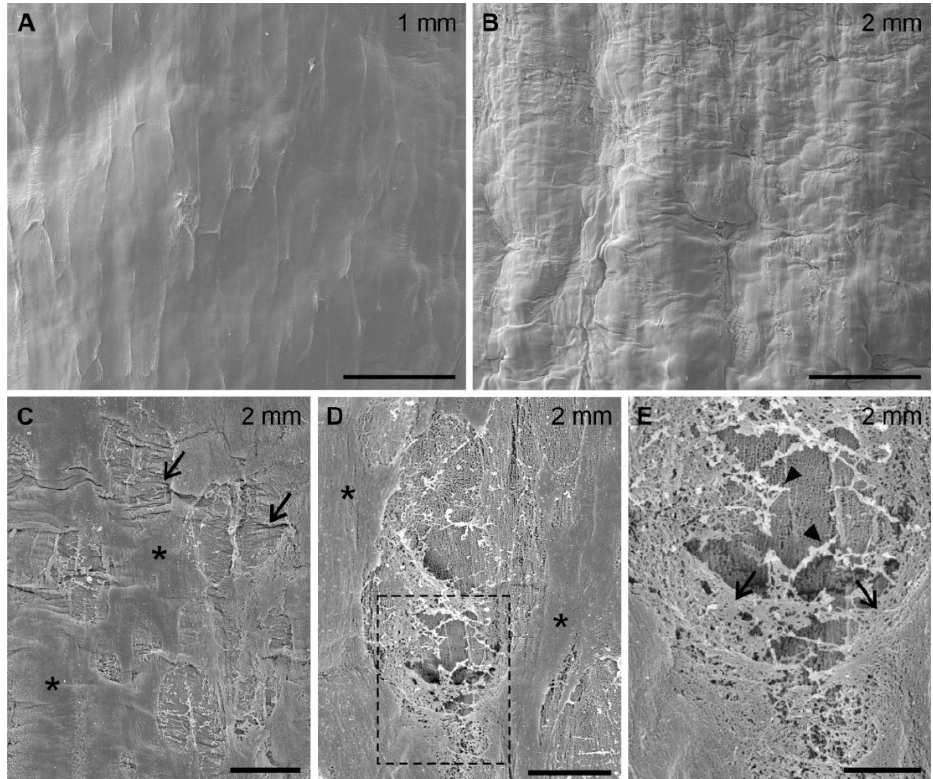
Figure 10. SEM micrographs of the epidermal surface of recovering maize roots below ( A ) and above ( B ) the boundary between the regions of living and dead cells (up to 1 mm and up to 2 mm from the root tip, respectively). ( C , D ) Subsequent enlargements of the root surface in ( B ). Arrows in ( C ) point to randomly distributed irregular damage and transverse microwrinkles, asterisks in ( C , D ) refer to areas of a compact structure occurring between the damage. ( E ) Further enlargement of the framed region in ( D ). Arrows and arrowheads indicate reticular network and thick fibrils, respectively. All image orientation is parallel to the root axis. Scale bars: 50 µ m ( A , B ), 10 µ m ( C ), 5 µ m ( D ), 2 µ m ( E